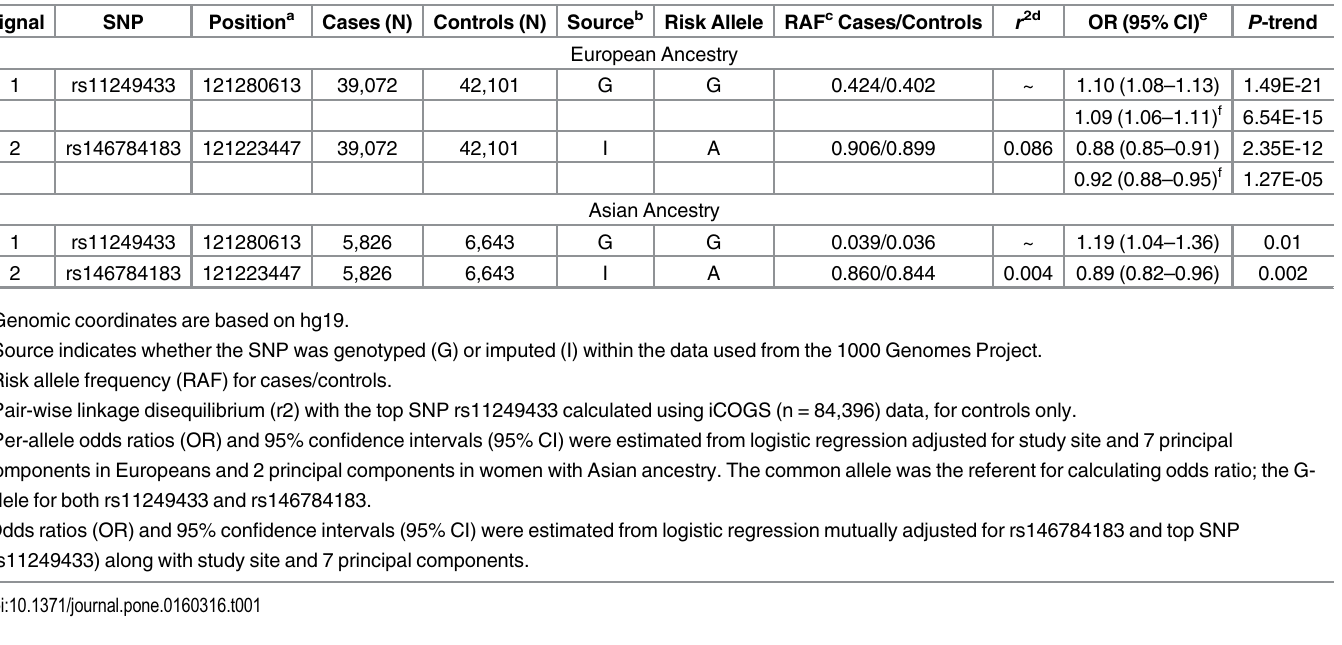
Breast cancer risk associations at the 1p11.2 locus